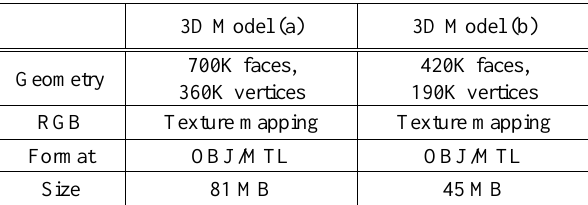
Table 1. Characteristics of the 3D overlays